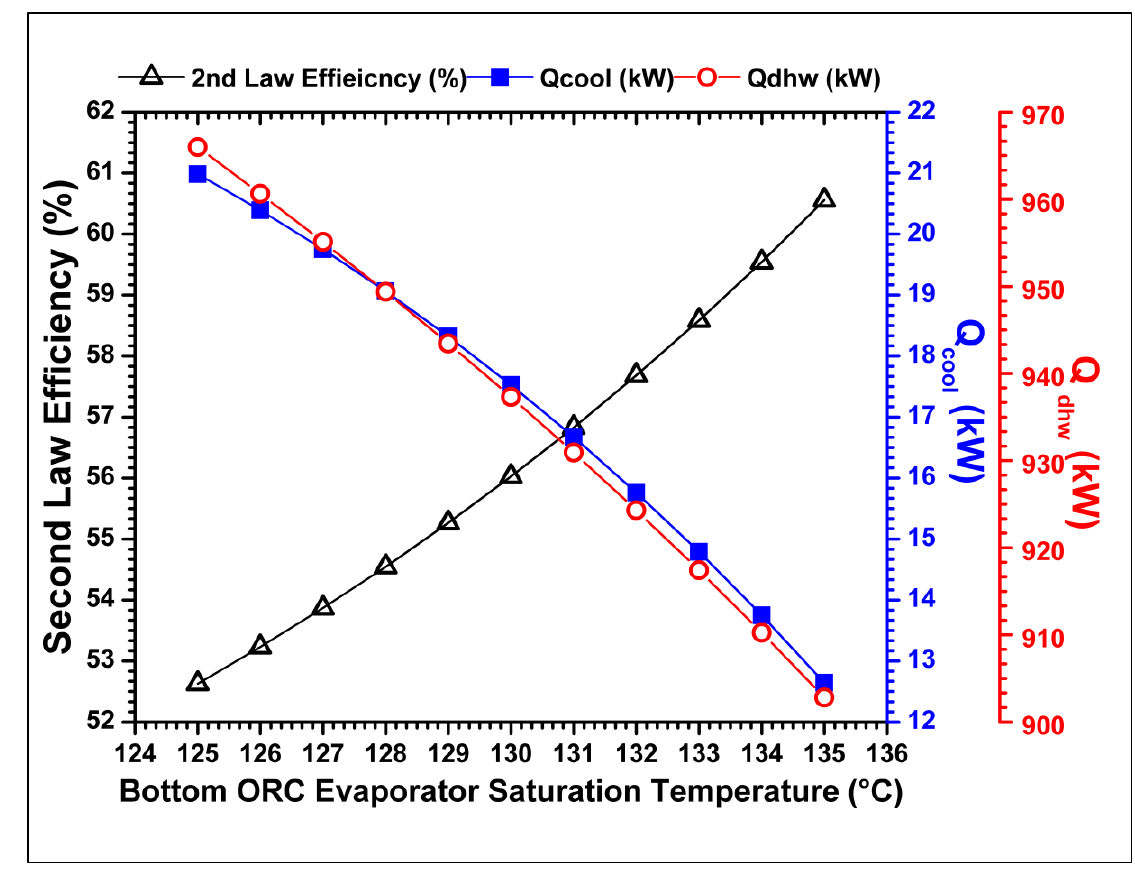
Figure 9. The variation of the cooling, heating, and second law efficiency against the saturation evaporation temperature of the low temperature heat source powered ORC.